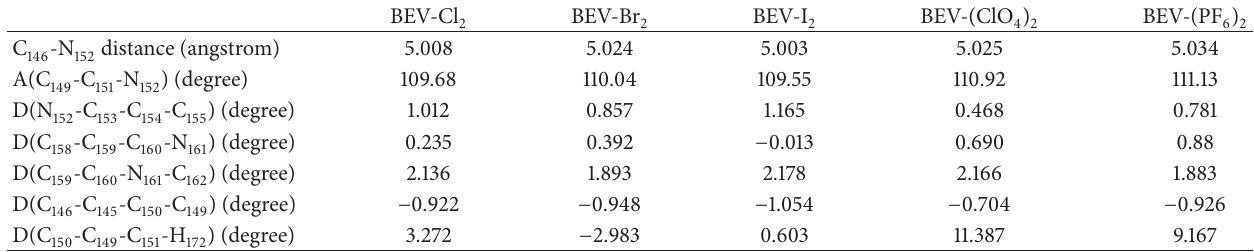
Table 1: The key optimized atom distances and angles for the including complexes in the ground states, calculated with DFT at the B3LYP/3- 21G level using Gaussian